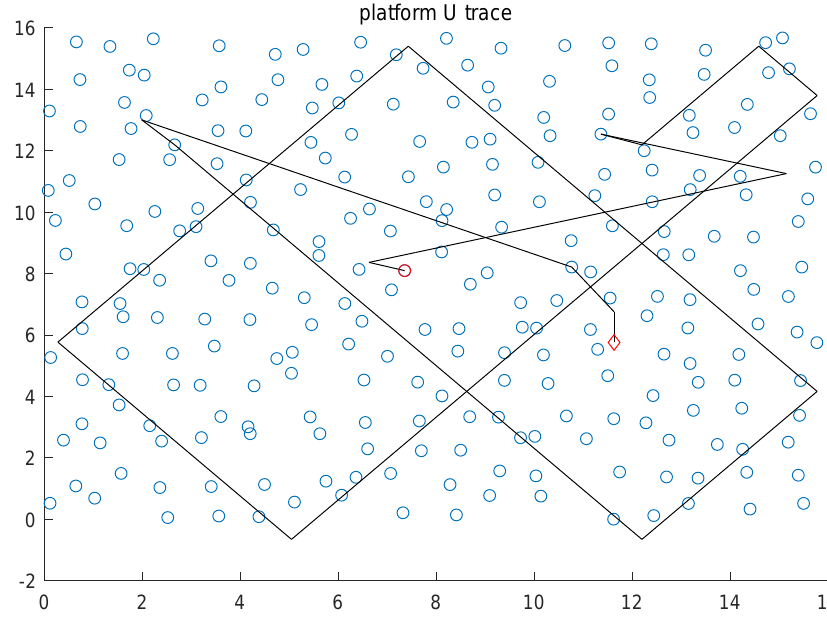
Figure 7. The figure is the trace diagram about how the platform seeks for station based on above rules in 1 time of simulation, where the red circle represents station position and the red rhombus is the starting position of platform (randomly), and the black lines represent the motion trace of the platform when it seeks for address. After entering the target network randomly, the platform in the diagram will detect according to the pre-determined trace (the pre-determined trace is not unique). Even if the upstream node is judged wrong in the early stage, there will be one dimension facing the station after boundary reflection, and reaching station node after many times of boundary reflection. (Platform motion trace is marked out for the purpose of better explaining how the platform seeks for